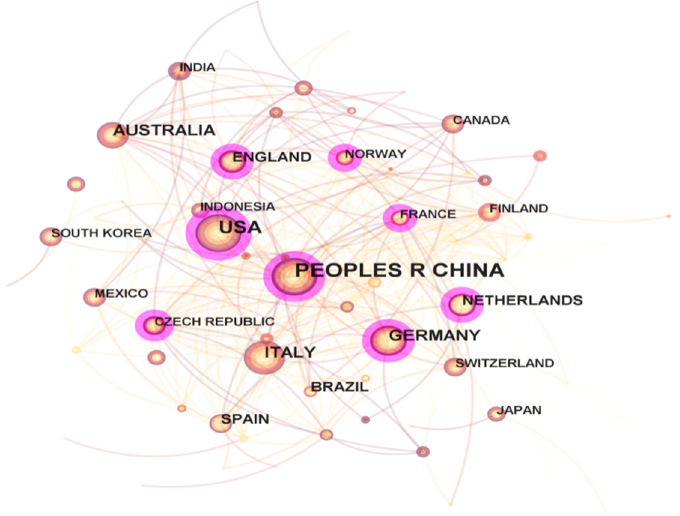
Figure 2. National cooperation in research on forest ecosystem services.